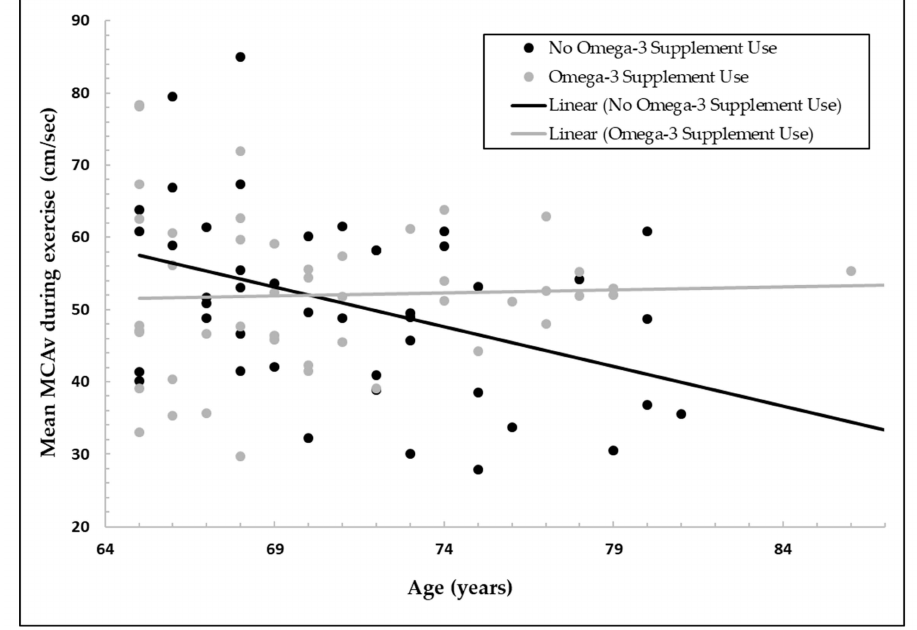
Figure 1. Middle cerebral artery velocity (MCAv; centimeters per second) during moderate-intensity exercise is shown as a function of age (years) for participants who reported omega-3 supplement use or no omega-3 supplement use. For the group not taking omega-3 supplements, increasing age was associated with a lower exercising MCAv, a surrogate measure of cerebral blood flow (CBF). In contrast, exercising MCAv was stable with increasing age in the group who reported taking omega-3